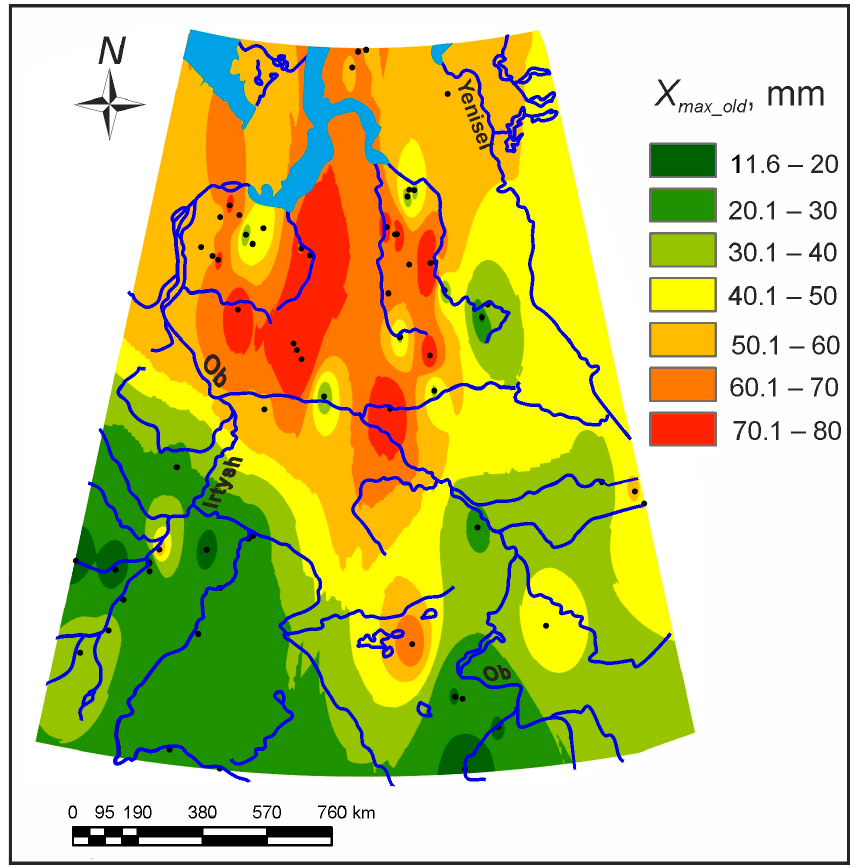
Figure 13. Distribution of reconstructed ancient effective maximum daily surface runoff depth X max _ old for unit basins on the West Siberian Plain. The main difference between the daily maximum surface runoff depth X max _ old during the Late Pleniglacial/Late Glacial and at the present time is the much higher values. Daily water input during snow thaw was 60–75 mm in the northern region (tundra and sparse forest) and 20–40 mm in the south (periglacial steppe). In a vast relatively homogeneous periglacial hyperzone [37], a spatial differentiation of X max _ old was lower than in the modern conditions. The mean daily maximum surface runoff depth for the entirety of West Siberia was about 46 mm, which is more than five times larger than the modern value. 3.4. The Possibility to Estimate Mean Annual Flow Characteristics As it is not possible to determine mean annual discharges of the ancient rivers di- rectly from their morphology, for this purpose, the method of paleohydrological analogue was proposed [38]: the runoff characteristics for the ancient and present-day river basins are similar if these basins have similar landscapes . The modern landscapes, which can be considered the closest analogues for periglacial landscapes of the East Euro- pean Plain 18 cal ka BP, were determined from paleofloristic data on ancient alluvial de- posits derived mainly from pollen analyses [17,18]. The most probable landscape ana- logues are intermountain basins of Altai and Sayan mountains. A similar climate on the plains exists in the open forest areas of Central Yakutian Plain (the Vilyui River basin) and